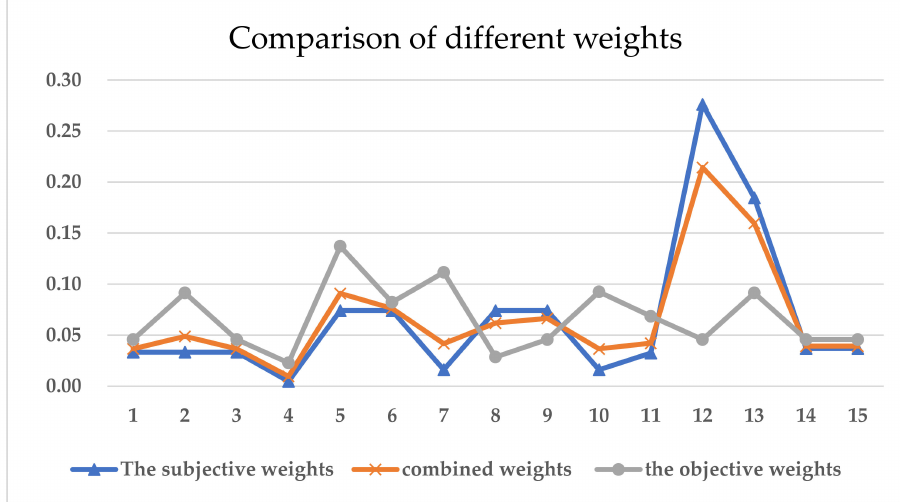
Figure 5. Comparison of different